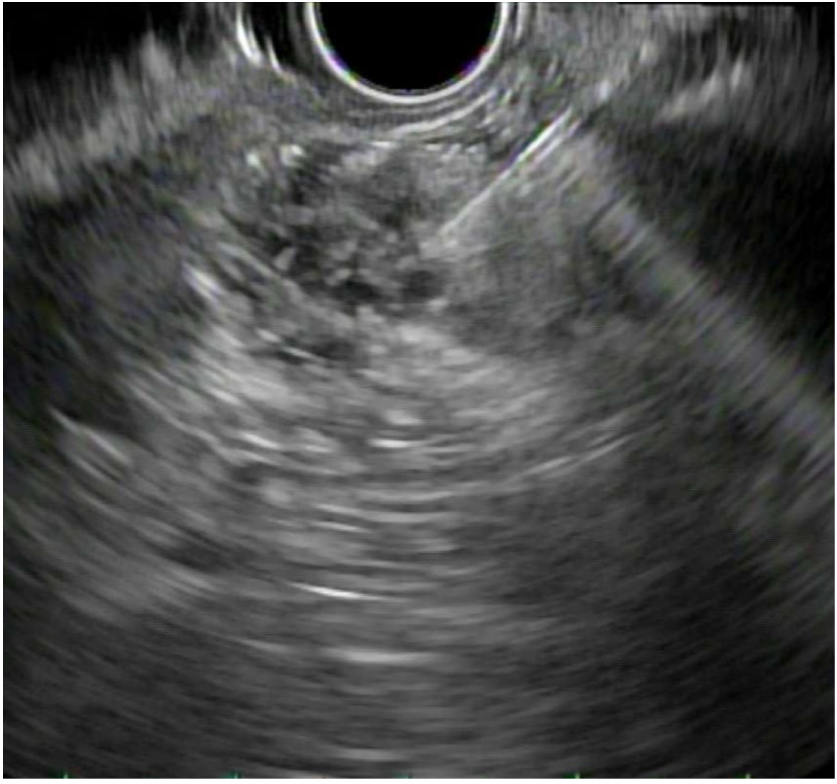
Figure 6. EUS Celiac Plexus Neurolysis (CPN): Endosonographic image of a celiac plexus